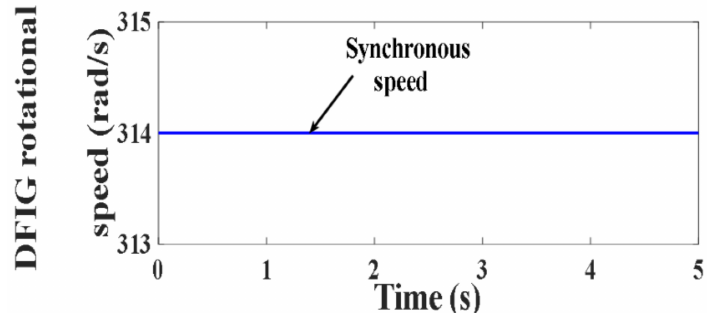
Figure 179. Prime mover operating speeds (rad/s).